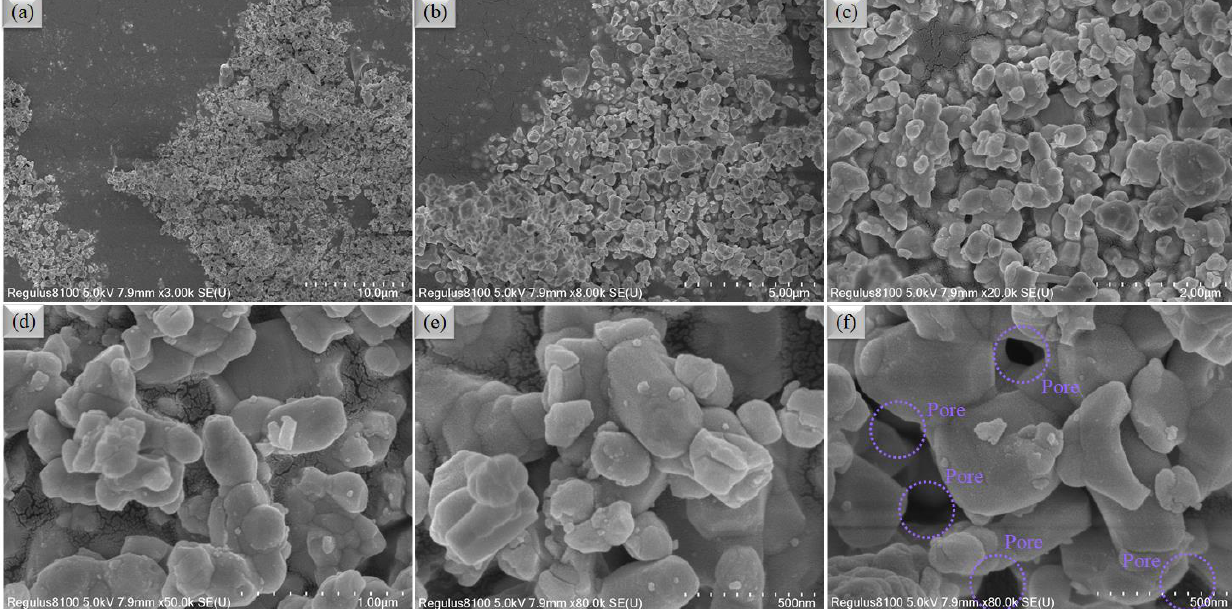
Figure 3a. The EDS mapping image of the chemical distribution of each element in LaFe 0.8 Gd 0.1 Ce 0.1 O 3- δ can clearly be seen. The elemental mapping image with mixed colors